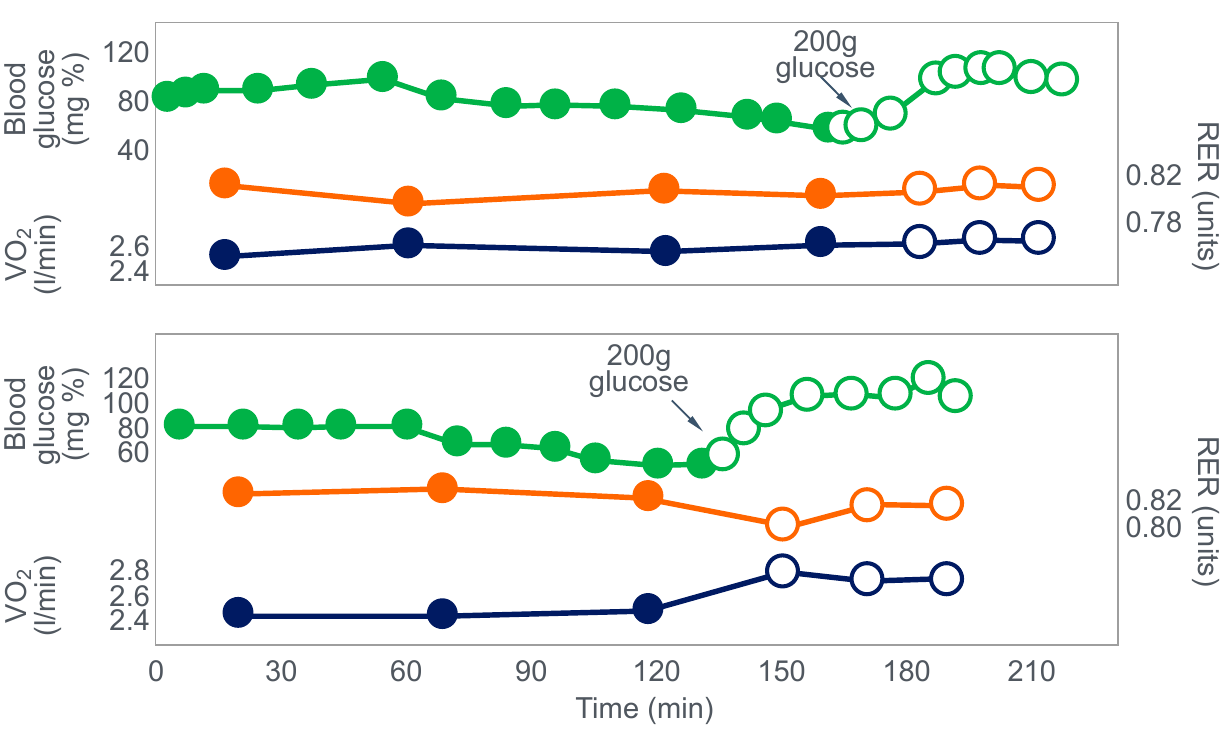
Figure 3. Effect on blood glucose concentrations, oxygen consumption (VO 2 ) and respiratory ex- change ratio (RER) of ingestion of 200 g of glucose at point of exhaustion in two athletes. Adapted with permission from ref. [14]. Copy-right 1939 Acta Physiologica (John Wiley and Sons). First, they confirmed Krogh and Lindhard’s observation that exercise performance was greatly impaired in subjects who had eaten a low-carbohydrate diet prior to the exer- cise bout. It is important to note here that this study was an acute (less than 7 days) dietary intervention. This becomes an important consideration subsequently. Figure 2 shows that when eating the low-carbohydrate diet, subjects could exercise for less than 90 min at a work rate they could sustain for up to 240 min when eating the high-carbohydrate diet. Second, blood glucose concentrations fell progressively during exercise in the low- carbohydrate group, reaching hypoglycaemic levels already within the first 30 min of ex- ercise (Figure 2). Clearly, the authors understood the importance of this finding because in their next series of experiments, they had subjects ingest 200 g of glucose at the point of fatigue. We can conclude that their goal was to test whether reversal of hypoglycemia would allow the subjects to continue exercising. Figure 3 shows that two subjects who ingested 200 g of glucose at the point of fatigue were able to continue exercising for another hour. In both, glucose ingestion rapidly nor- malized their low and falling blood glucose concentrations. Oxygen consumption (VO 2 ) and RQ increased in one subject (bottom panel), indicating an increased work output.